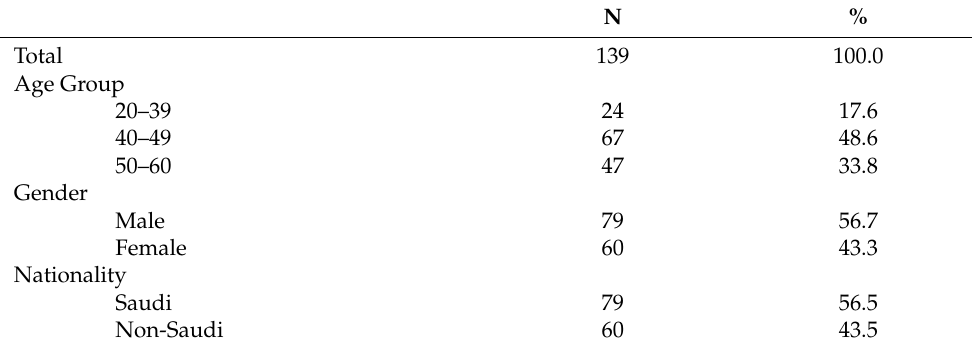
Table 1. Characteristics of the Study